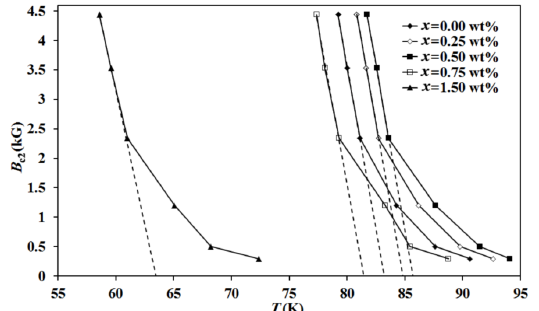
( ) B T versus T for (BaSnO 3 ) x /BiPb- c2